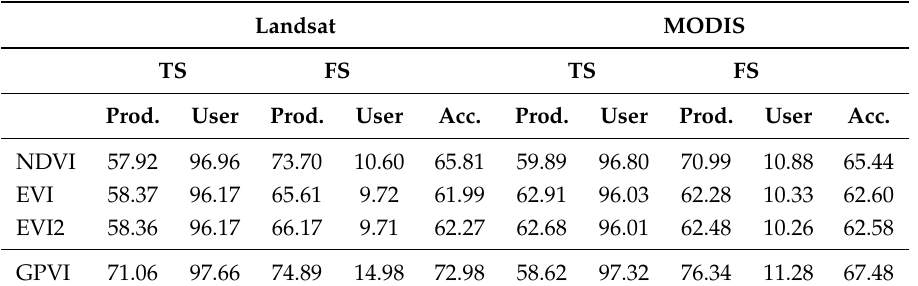
Table 5. Normalized accuracies ( Acc. ) and user’s ( User ), and producer’s (Prod.) accuracies per class for typical savanna ( TS )/forested savanna ( FS )